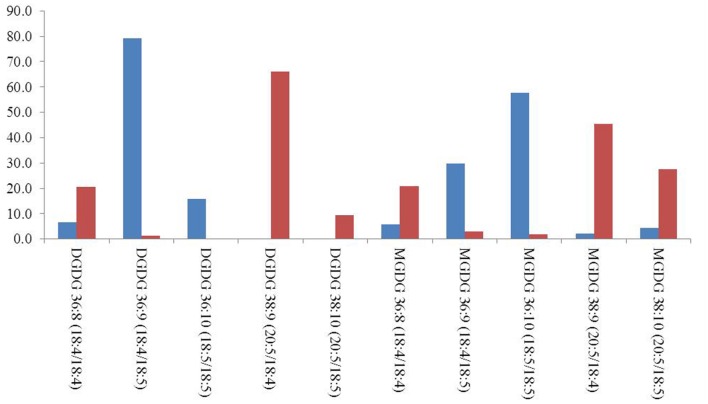
Relative distribution of most abundant MGDG and DGDG molecular species in B. tenuissima (blue) and C. cornutum (red) dinoflagellates. Only species above 2% were considered.